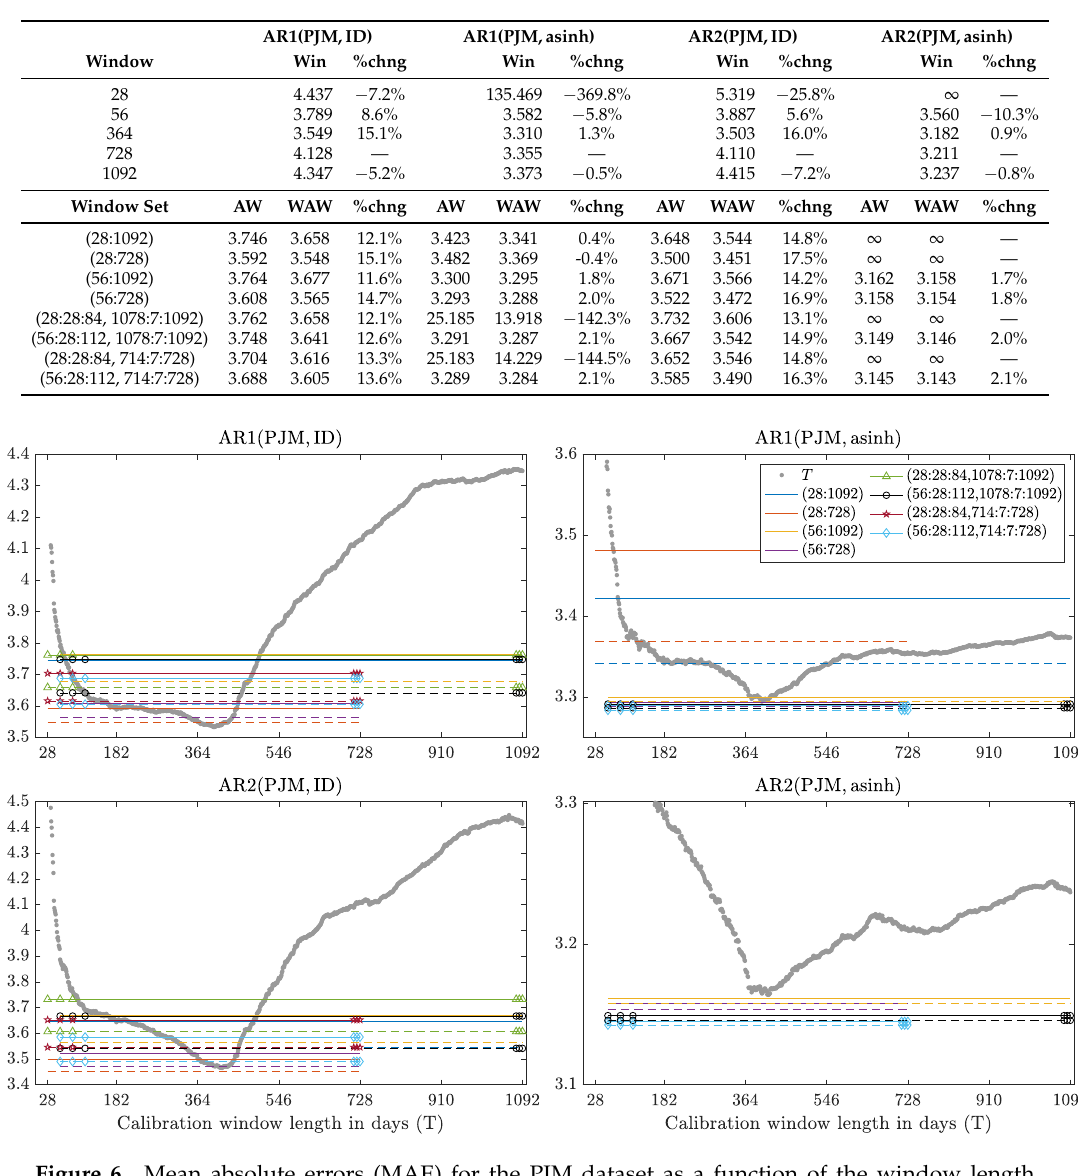
Figure 6. Mean absolute errors (MAE) for the PJM dataset as a function of the window length T = 28,...,1092 (gray circles) and obtained by combining forecasts (the color/line/symbol scheme is the same as in Figure 4). MAEs are plotted for AR1 ( top ) and AR2 models ( bottom ), calibrated to raw ( left ) and asinh -transformed prices ( right ). Note the different scales. Out-of-range lines or symbols are not